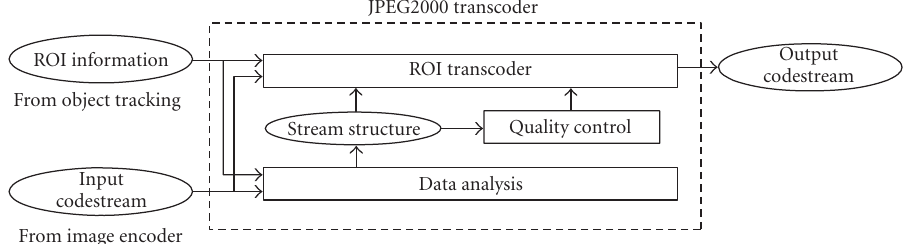
Figure 2: JPEG2000